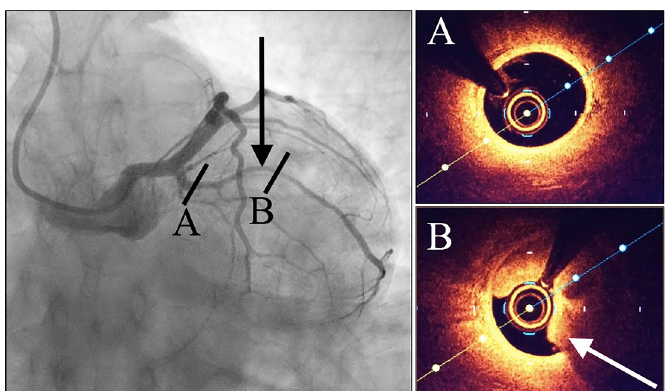
Image 2. Coronary catheterization images. Fluoroscopy is shown on the left, and intracoronary optical coherence tomography (OCT) is shown on the right. The black arrow indicates the lesion on angiography. The white arrow indicates intramural hematoma on OCT. Letters A and B signify locations along the